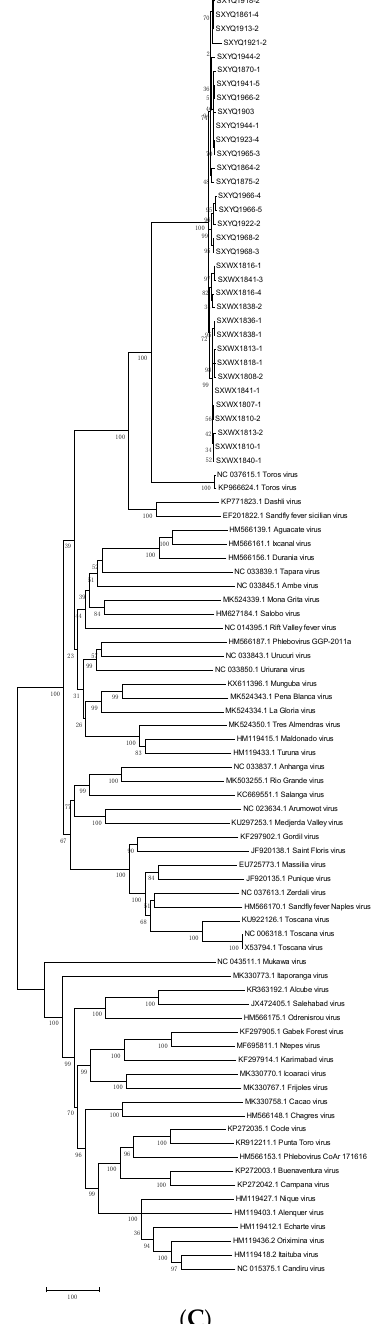
Figure 4. Molecular phylogenetic analysis of viral gene segments. Note: (1) A comparison of the gene sequences and related information of phleboviruses recently identified by the International Committee on Taxonomy of Viruses in 2020 via molecular genetic phylogenetic analysis. (2) ( A ) Phylogenetic analysis of the viral L segment sequence. ( B ) Phylogenetic analysis of the viral M segment sequence. ( C ) Phylogenetic analysis of the viral S segment sequence. MEGA6.0 software was used to perform the phylogenetic analysis, using the neighbor-joining method with a bootstrap value of